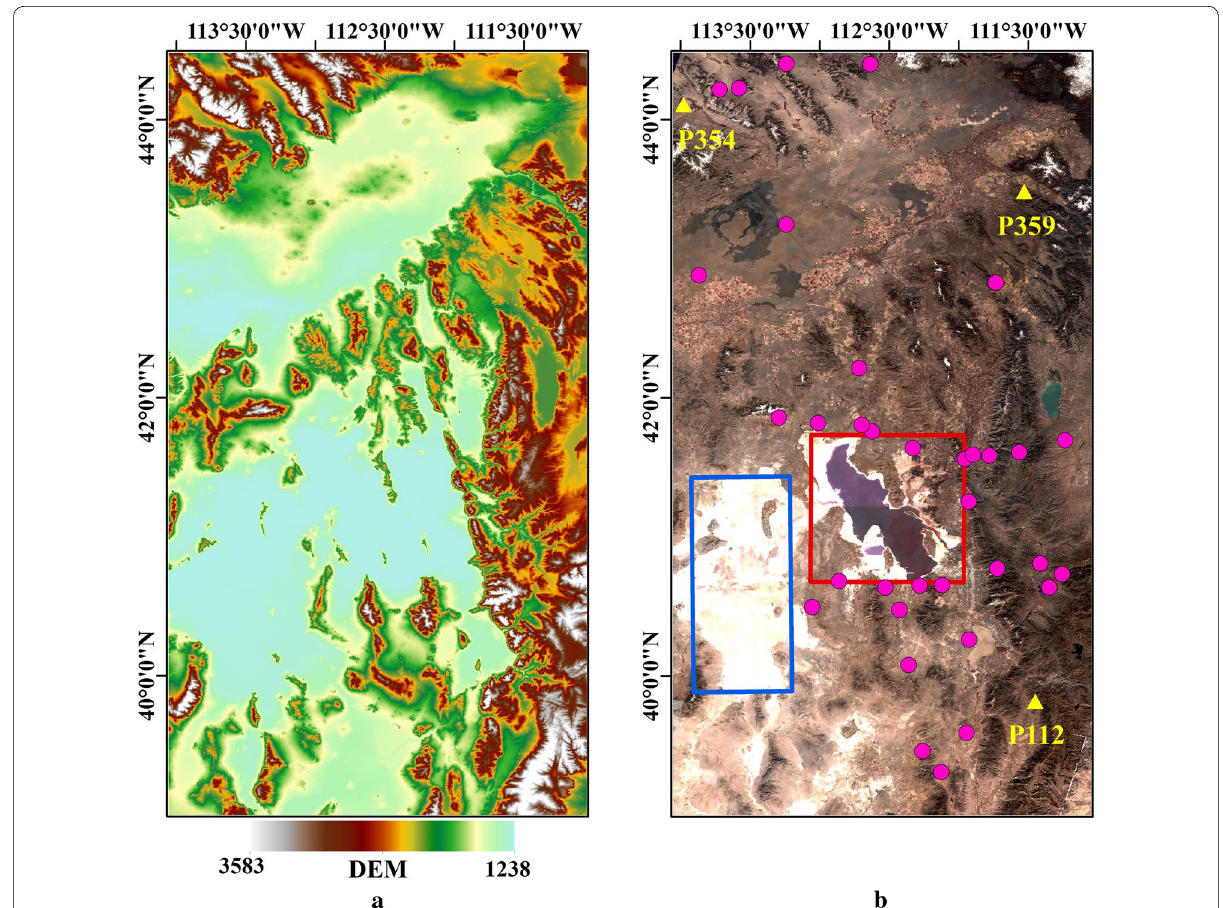
Fig. 5 DEM map and satellite map of the study area: a DEM map; b Landsat